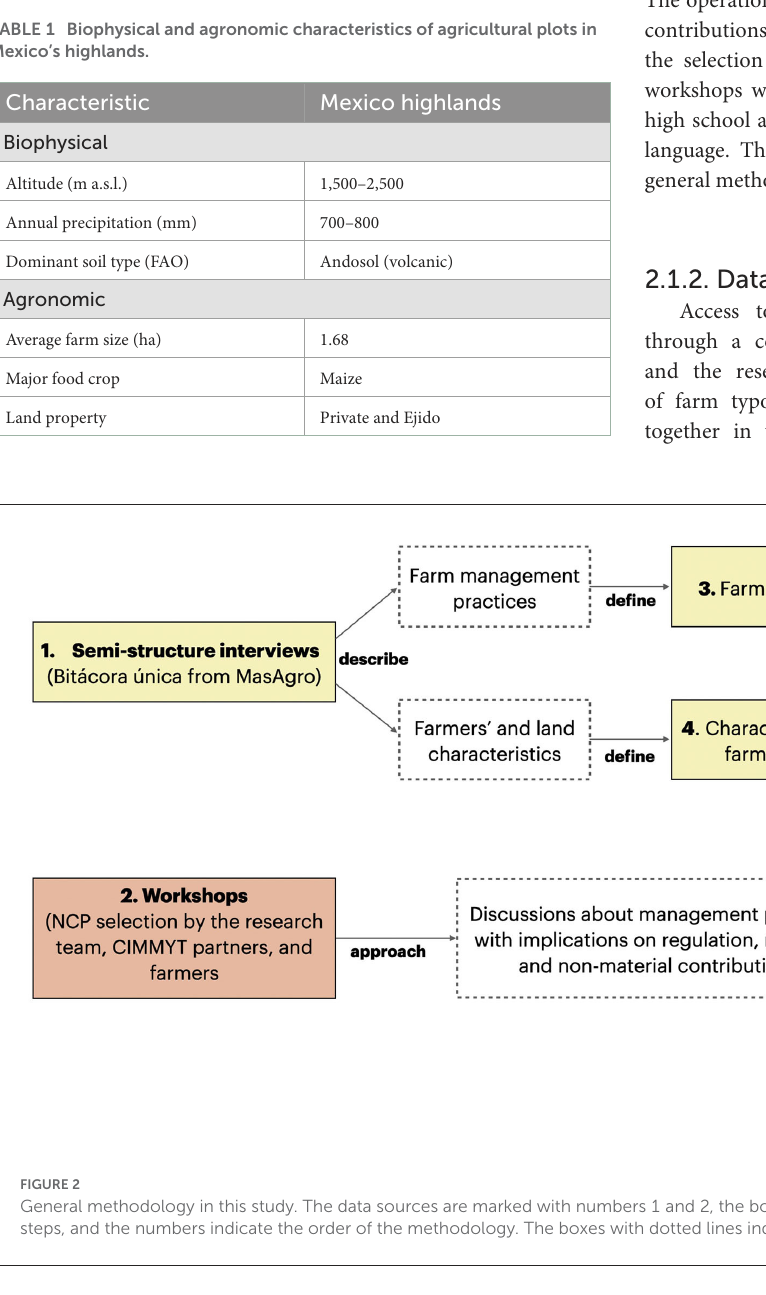
FrontiersinSustainableFoodSystems